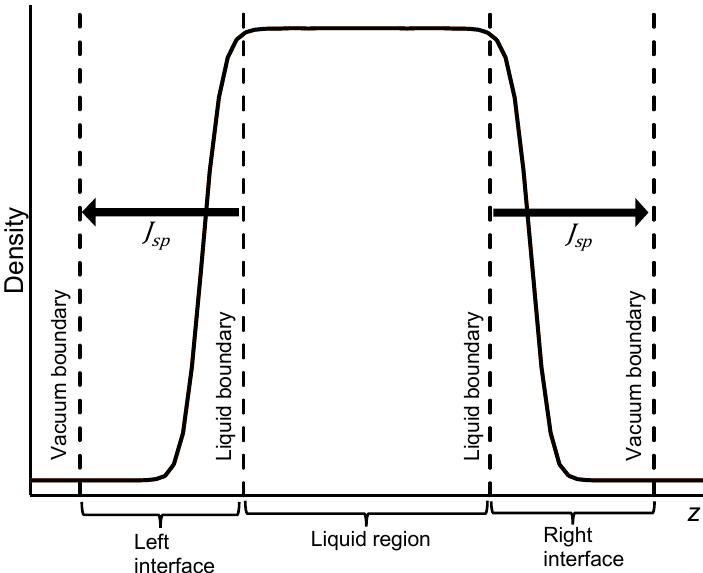
Figure 3. Deletion vacuum simulation scheme with denoted interface region boundary positions and mass fluxes through the interfaces. The density profile for the scheme was obtained from the production run of the liquid-vapor phase equilibria simulation.